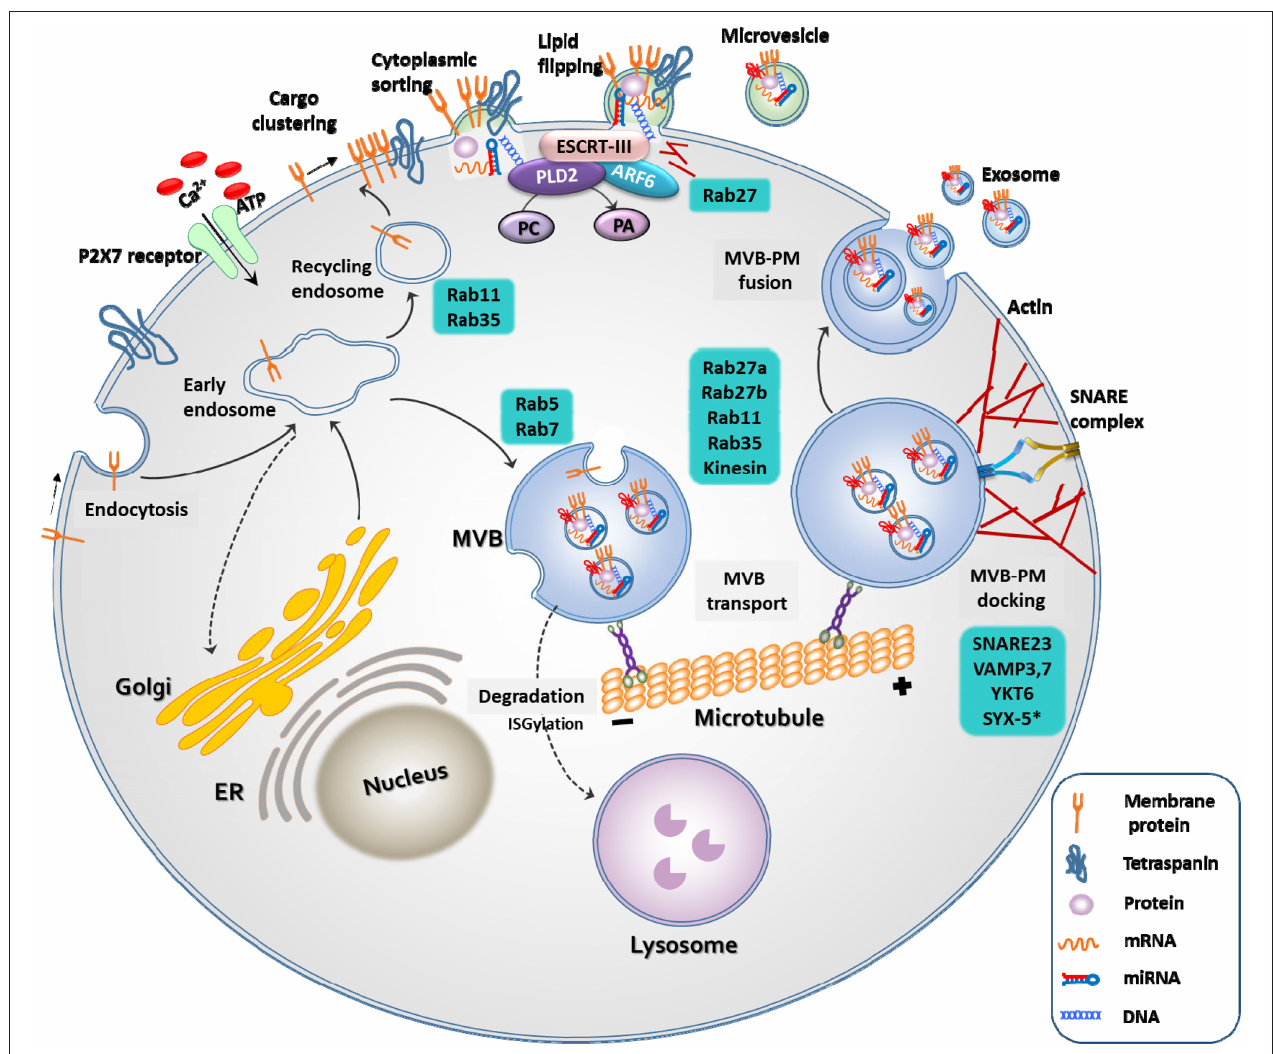
FIGURE 1 | Biogenesis of extracellular vesicles. EVs are released through two different pathways. When extracellular adenosine triphosphate (ATP) increases in response to external stimuli, the P2X7 receptor opens and calcium ions enter the cell. Membrane-associated proteins, tetraspanins, and cytoplasmic cargos are clustered in discrete membrane of the plasma membrane for microvesicles. The cargo of MVs are composed of cytoplasmic proteins, mRNAs, miRNAs, and DNAs. Similar to exosomes, RAS-related protein (RAB), actin, the endosomal sorting complex required for transport (ESCRT), ADP ribosylation factor 6 (ARF6) and phospholipase D2 (PLD2), and soluble N-ethylmaleimide-sensitive protein receptor (SNARE) proteins play important roles in MV release. However, MVs differ from exosomes in that they bud directly through flipping of lipid from the plasma membrane. The cargo of multivesicular bodies (MVBs) are either derived from endocytosis of the plasma membrane or from the trans-Golgi network. The reverse flow in the direction of the Golgi or recirculation to the plasma membrane is controlled by various Rab GTPases. Once MVB has matured, it is transported to the plasma membrane along the microtubule, and not by lysosomes. As a final step in exosome release, MVBs are docked and fused with the plasma membrane. Rab, actin, and SNARE proteins play important roles in these exosome release